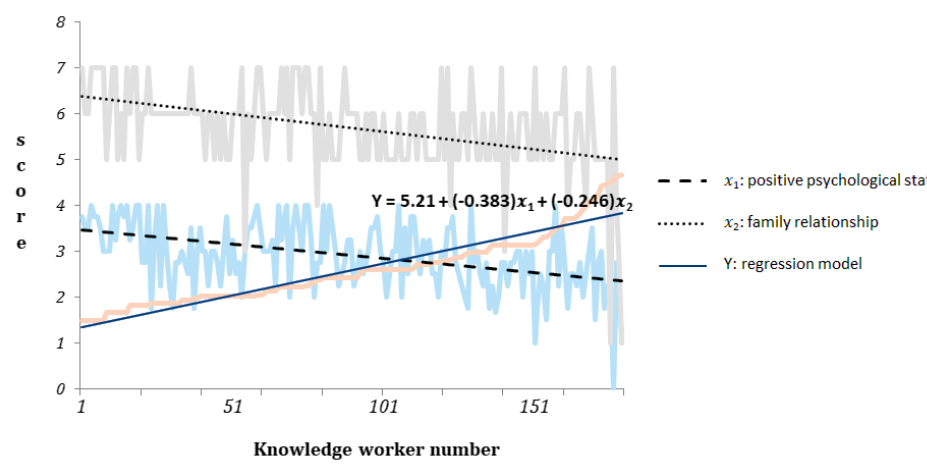
Figure 2. Graphs of regression programs for depression - individual characteristics.